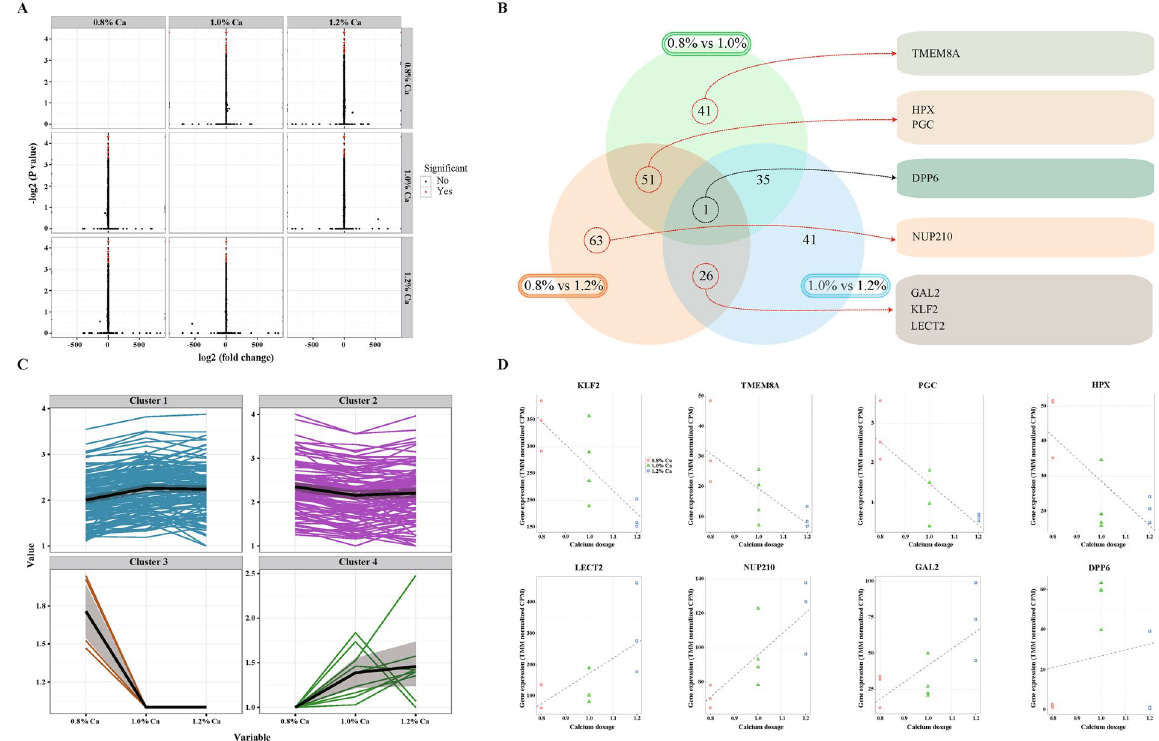
Figure 2. Identification of DEGs between kidney samples from broiler chickens fed diets containing 0.8, 1.0, and 1.2% Ca using both cufflinks and edgeR. ( A ) Volcano plots explore the relationship between fold-change and significance. ( B ) Venn diagram, comparing DEGs between pairs of conditions (0.8 versus 1.0, 0.8 versus 1.2, and 1.0 versus 1.2% Ca). The number of DEGs is indicated in the diagram. ( C ) Partitioning around medoids clustering with Jensen-Shannon distance for a CuffGeneSet. ( D ) Scatterplots of eight common DEGs that were identified by both cufflinks and edgeR.